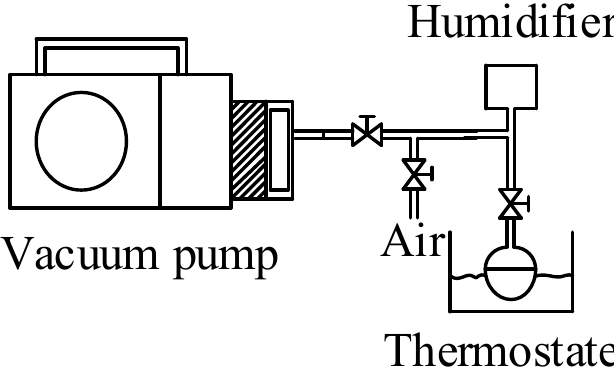
Figure 1. Measuring system for the moisture retention of emulsion.